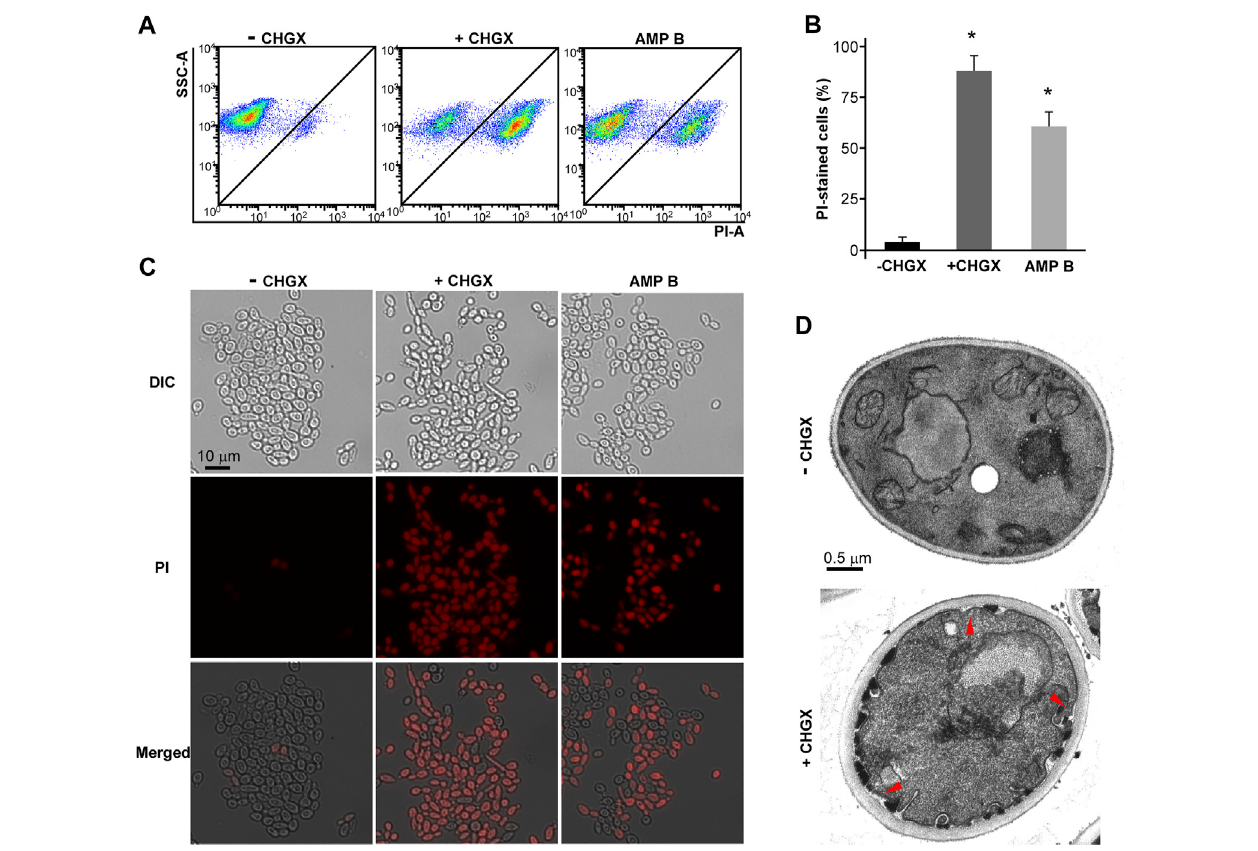
FIGURE 5 | CHGX water-extract causes cell membrane damage. SC5314 cells were used for representative strain of C. albicans. SC5314 cells (2 × 10 6 cells/ml) were incubated with or without 20 mg/ml CHGX water-extract in Lee ’ s glucose medium for 3 h at 30 ° C. (A – C) PI staining assay. Cells were harvested and stained with red PI dye for fl uorescence-activated cell sorting analysis (A) and fl uorescence microscopy (C) . (B) The percentages of PI-stained cells. AMPB-treated cells were severed as positive control. The data were presented as mean ± SD of three independent experiments according to fl uorescence microscopy assay in panel C. SSC-A, side scatter area; PI-A, propidium iodide area. One-way analysis of variance (ANOVA) was used to compare differences between drug treated and untreated samples as indicated; *, p < 0.05. (D) TEM assay. The red arrows indicated cellular membrane damage.